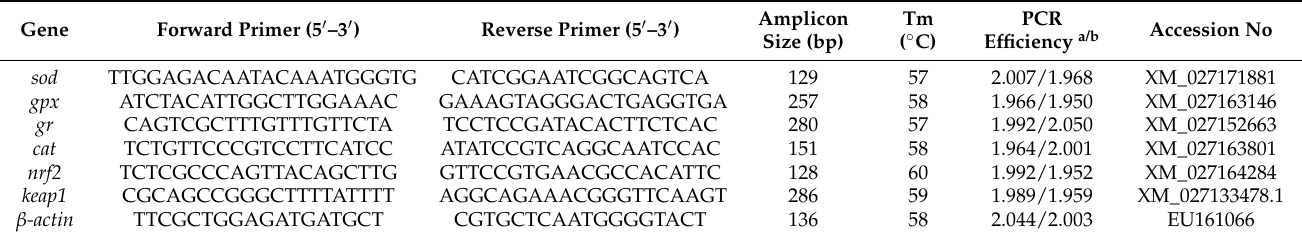
Table 2. Sequences of the primers used for qRT-PCR analysis in yellow